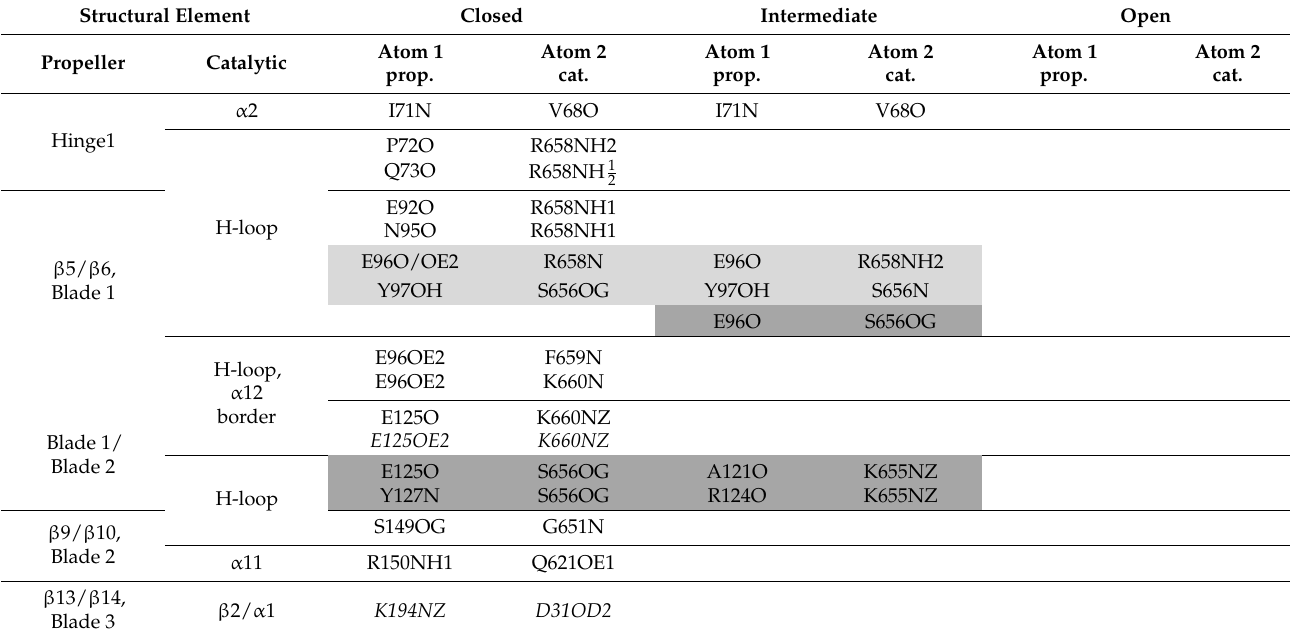
Table 2. Polar contacts in the interface between the catalytic and β -propeller domains in the three states of